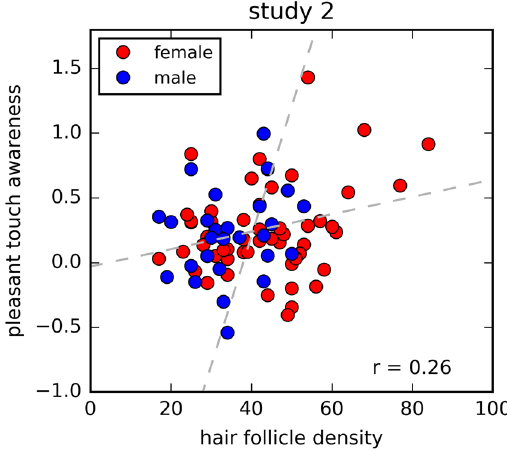
Figure 4. Affective touch perception in relation to HFD in study 2. There was a positive correlation between pleasant touch awareness and HFD in study 2 across all participants. The dotted lines represent the two regression lines obtained by regressing pleasant touch awareness on hair follicle density and vice versa. The depicted r represents the Pearson correlation